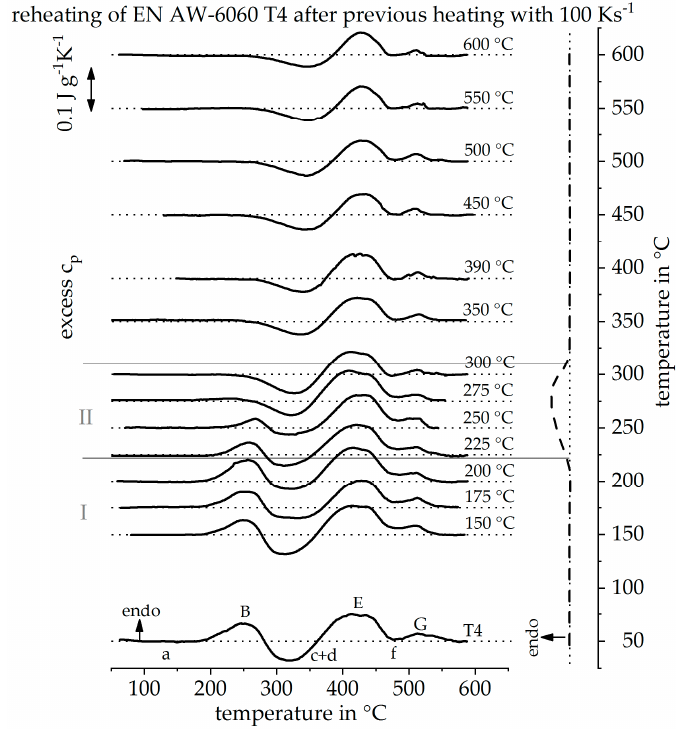
Figure 15. Reheating curves of the alloy EN AW-6060 T4 after a heat treatment with a heating rate of 100 Ks − 1 up to different maximum temperatures and the resulting reconstructed DSC heating curve at 100 Ks − 1 .